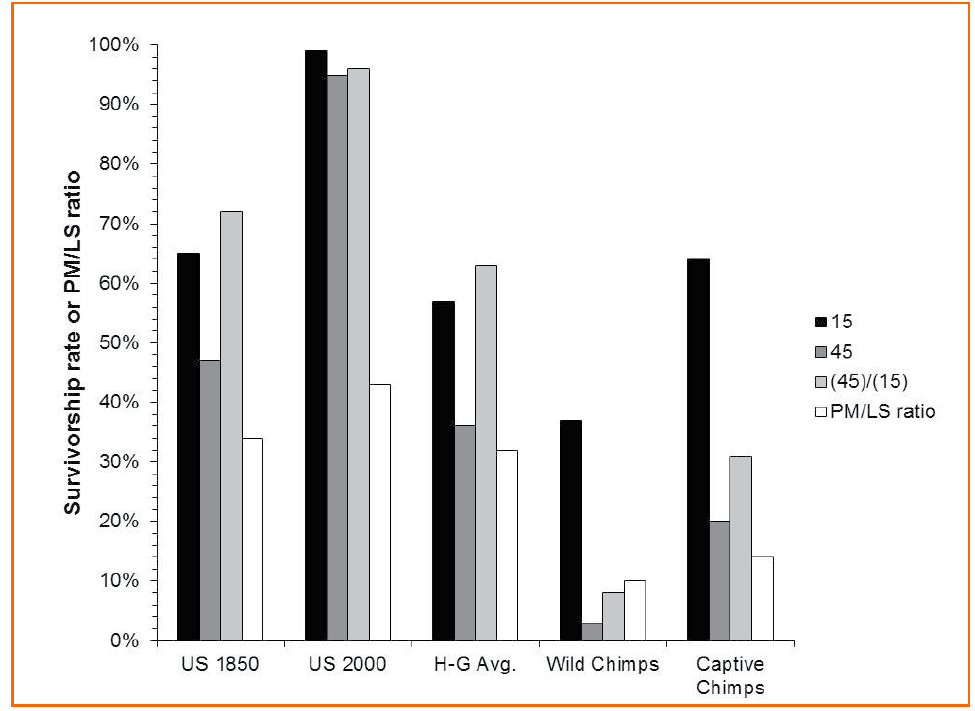
Figure 4: Survivorship from birth to age 15 years (black bars) and birth to age 45 years (dark gray bars); conditional survivorship from 15-45 years (light gray bars); and PM/LS ratio, the average postmenopausal lifespan (PM) remaining at age 45 years as a percentage of total lifespan (LS), calculated as e45/(e45+45), where e45 is the life expectancy at age 45 years. United States (US) data for 1850 (Haines 1994) and for 2000 (Bell and Miller 2005); hunter-gatherer (H-G) and chimpanzee data (Gurven and Kaplan